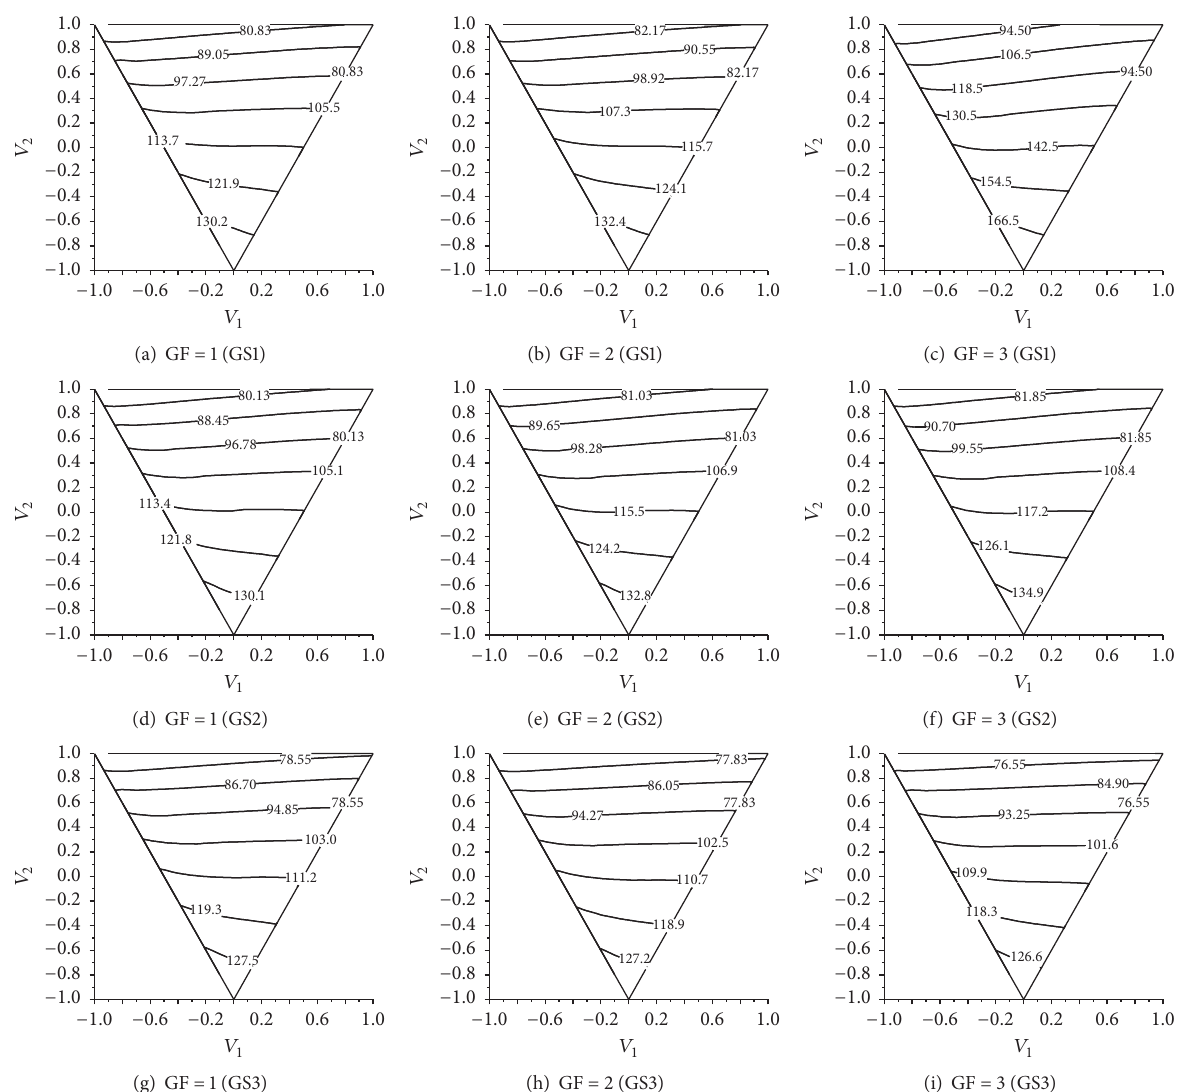
Figure 5: Flutter velocity contours for orthotropic sandwich panel ( 𝑉 3 = 0 ) with various gradient